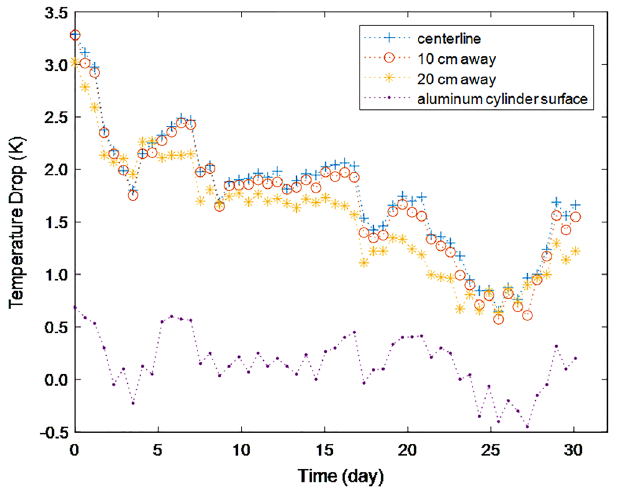
Figure 2. The temperature drops at 90 cm height compared to the temperature at 10 cm height for an air column of 60 cm diameter, measured with sensors located at three different radial positions for 30 days from June 18th, 2021, in Gyeongju,